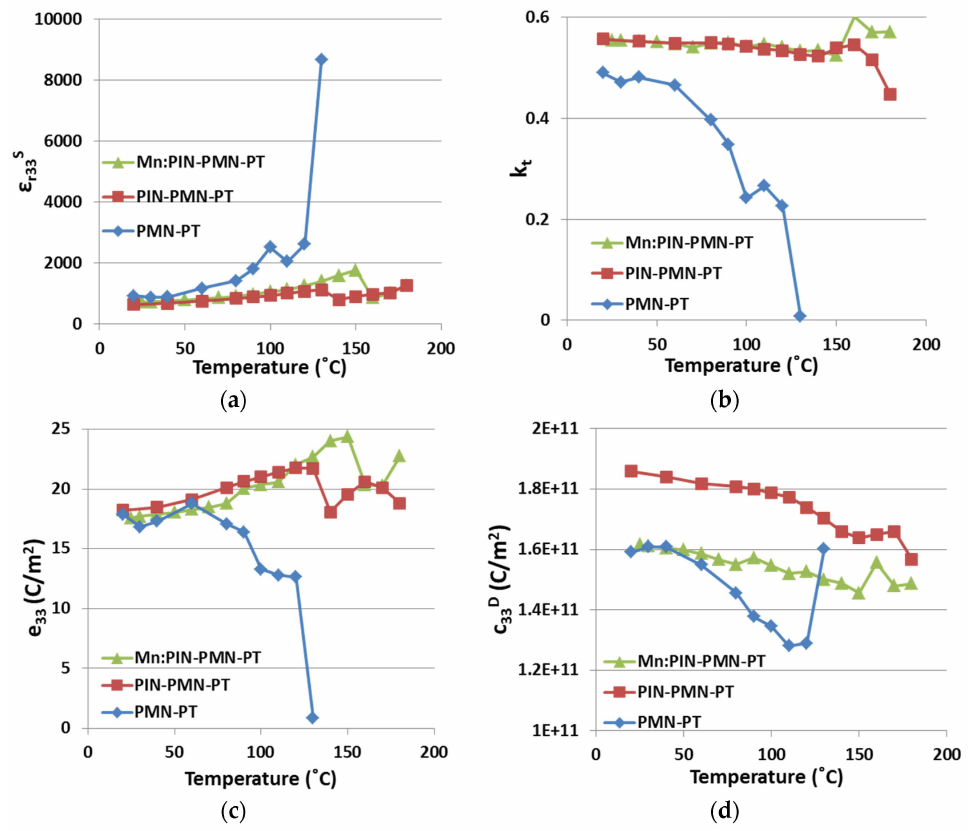
Figure 4. The effect of T on three generations of piezocrystals ( a ) ε r 33 S ; ( b ) k t ; ( c ) e 33 ; and ( d ) c 33 D . (PMN-PT results adapted from